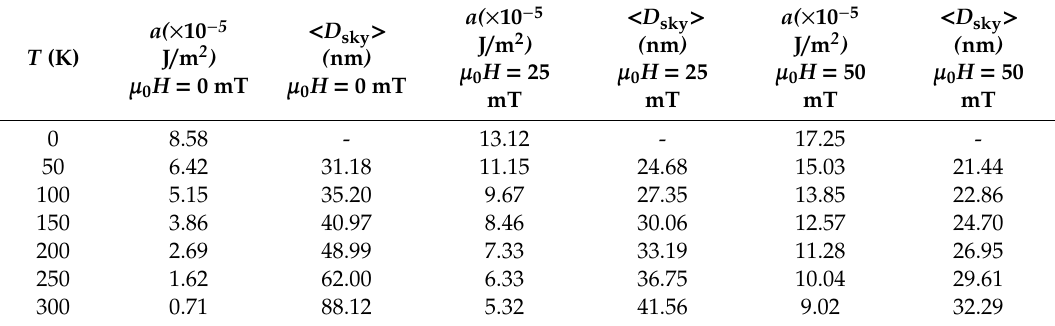
Table 1. Calculated a and < D sky > used in the numerical calculations 39 .